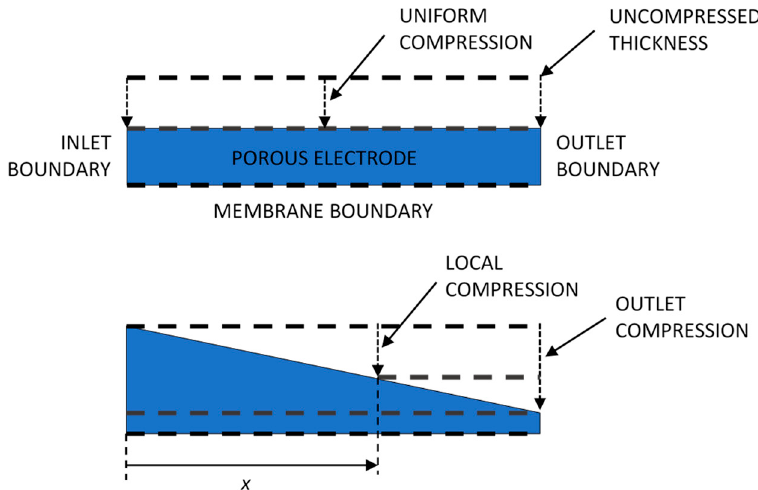
Figure 7. Diagram showing the definition of uniform ( top ) and variable ( bottom ) compression as a function of position on the x-axis between the inlet and outlet.